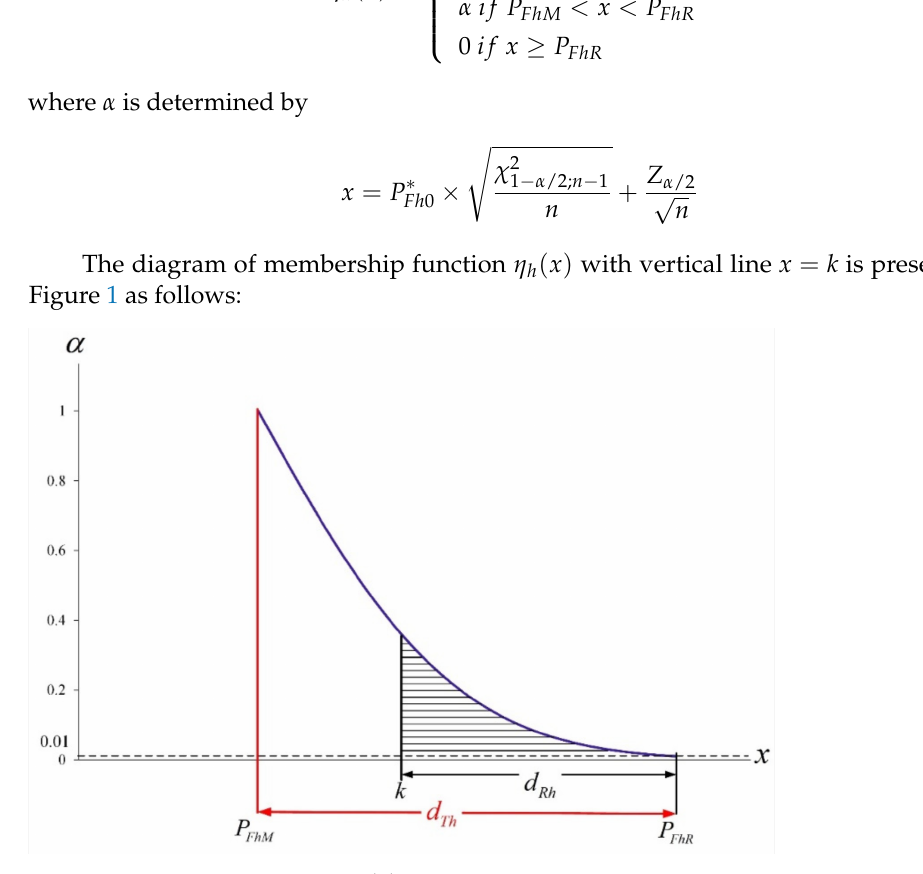
Figure 1. Membership function η h ( x ) with vertical line x = k